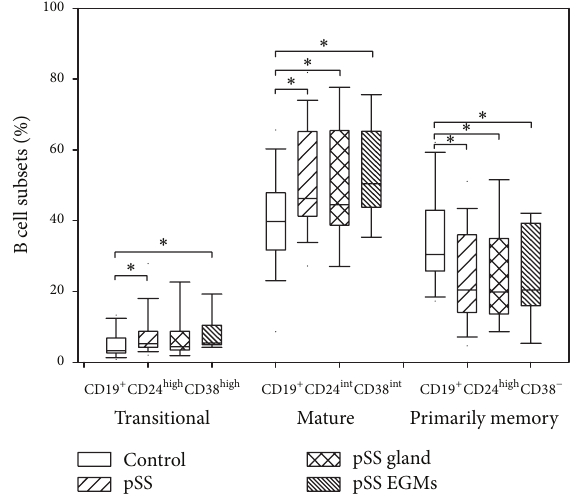
Figure 4: Percentages of transitional, mature, and primarily mem- ory B cells. Box plots show median, upper, and lower quartiles; lines extending vertically from boxes indicate 5–95 percentile ranges. Statistically significant differences are indicated by ∗